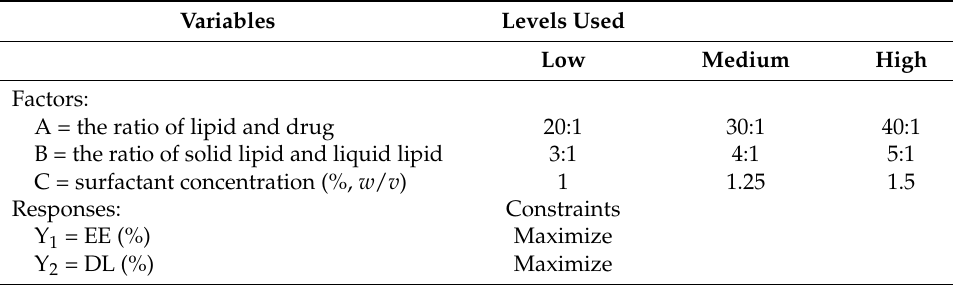
Table 2. Factors and responses for the BBD